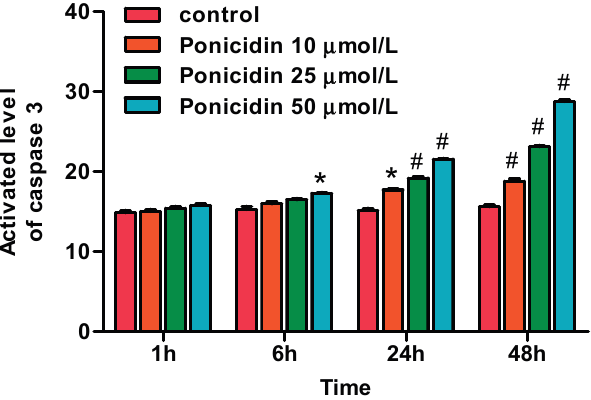
Figure 6. Effects of ponicidin on the activity of caspase-3 in MKN28 cells. After treatment, the activity of caspase-3 in MKN28 cells was analyzed by the caspase-3 assay kit. Ponicidin treatment time- and dose-dependently increased the activity of caspase-3 of MKN28 cells. * p < 0.05, # p <